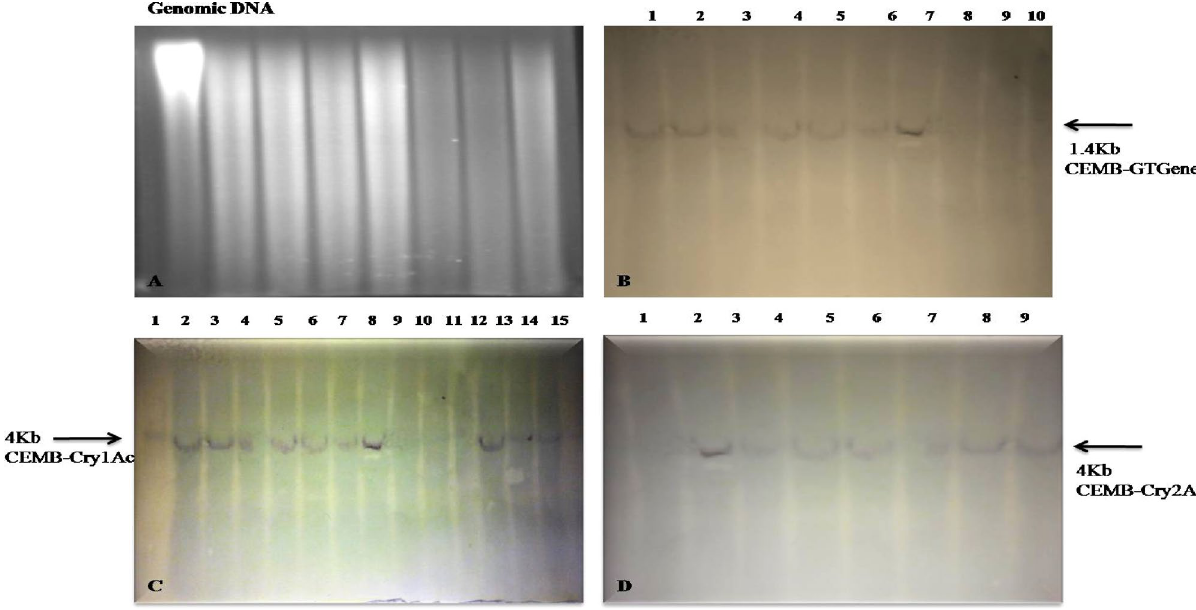
Figure 7. Southern Blot analysis of the transgenic sugarcane plants (CEMB- Cry 1Ac, CEMB- Cry 2A and CEMB- GTGene) in V 0 -generation. ( A ) Denaturing of genomic DNA. ( B ) Lane 1: Positive control, Lane 2–14: Southern DNA hybridization of transgenic sugarcane plants with CEMB-GTGene probe. ( C ) Lane 1: Positive control, Lane 2–15: Southern DNA hybridization of transgenic sugarcane plants with CEMB- Cry 1Ac probe. ( D ) Lane 1: Positive control, Lane 2–9: Southern DNA hybridization of transgenic sugarcane plants with CEMB- Cry 2A probe.